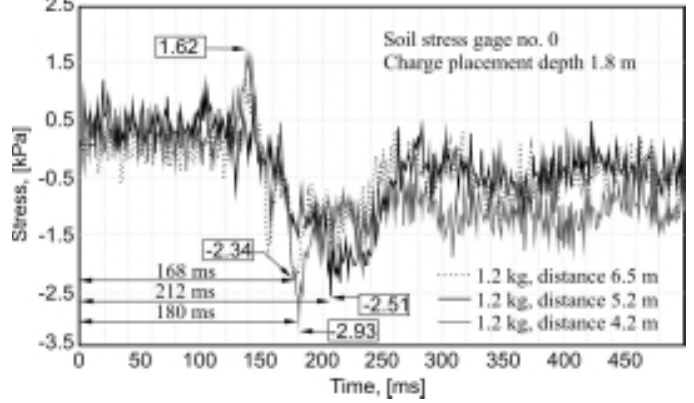
Fig. 7. Time history of normal soil stress σ h measured by gage No. 0 with the barrier.